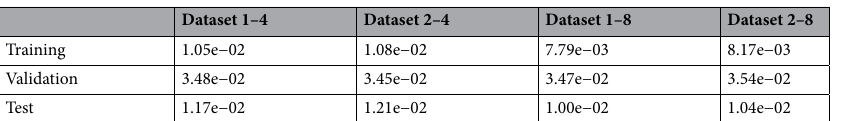
Table 3. The average RMSE of ten simulations obtained with the GRU model, for the two datasets and two sizes of the recurrent layer (4 and 8 hidden